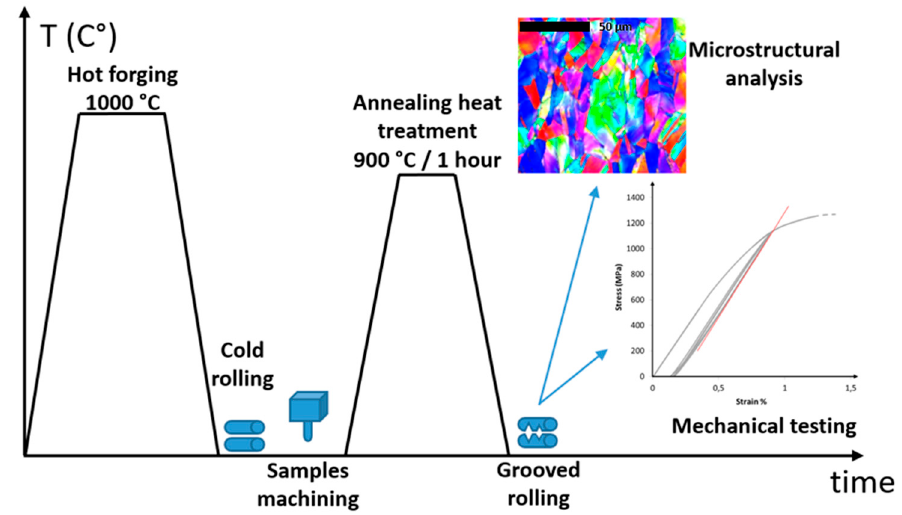
Figure 2. Graphical representation of samples production procedure and characterization.